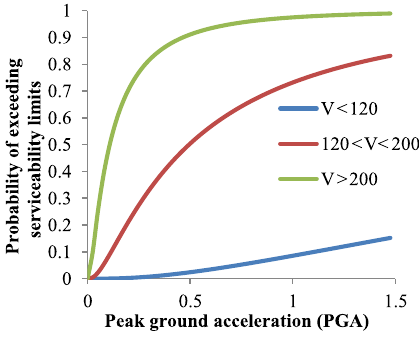
Figure 8. Probability of Exceeding/PGA.